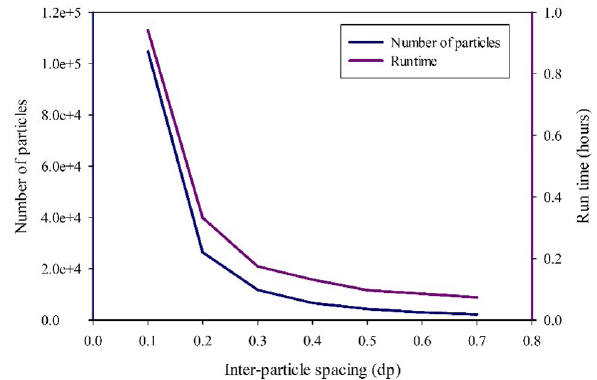
Figure 30. Number of particles and runtime for the different reso- lutions.